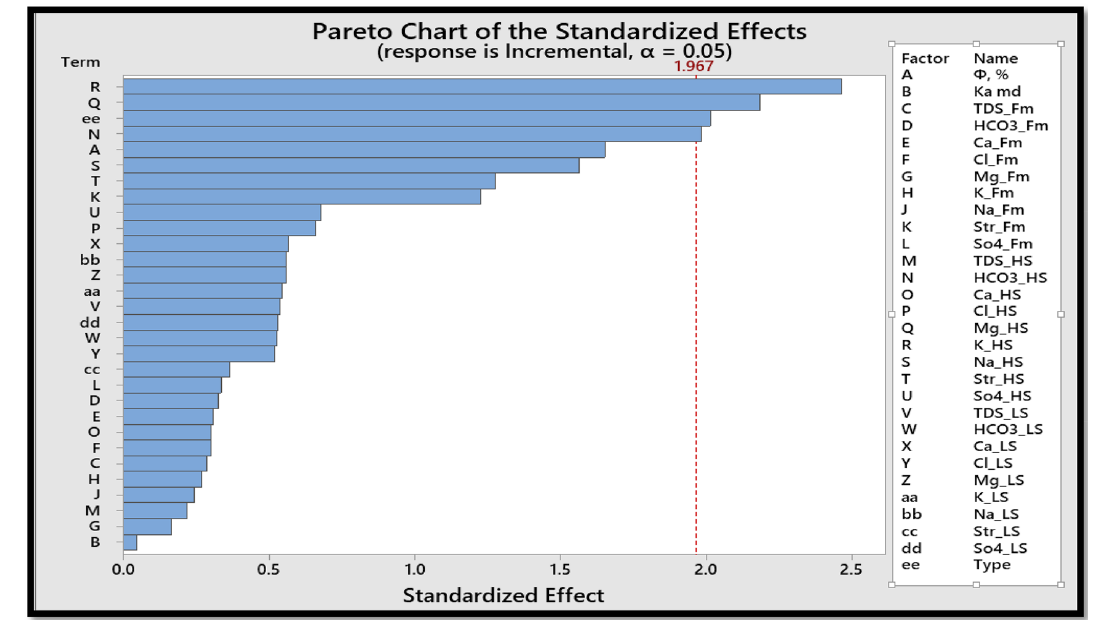
Fig. 8 Pareto chart using the datasets (without considering clay properties) of the secondary and tertiary stages